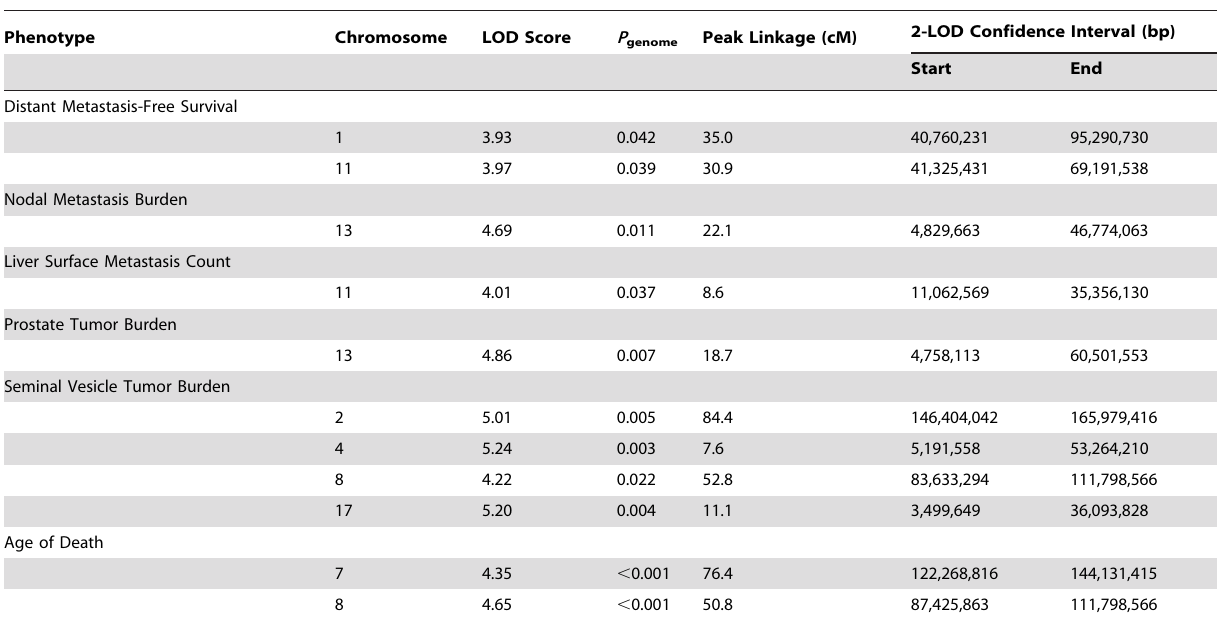
Table 1. QTLs identified in (TRAMP 6 NOD/ShiLtJ) F2